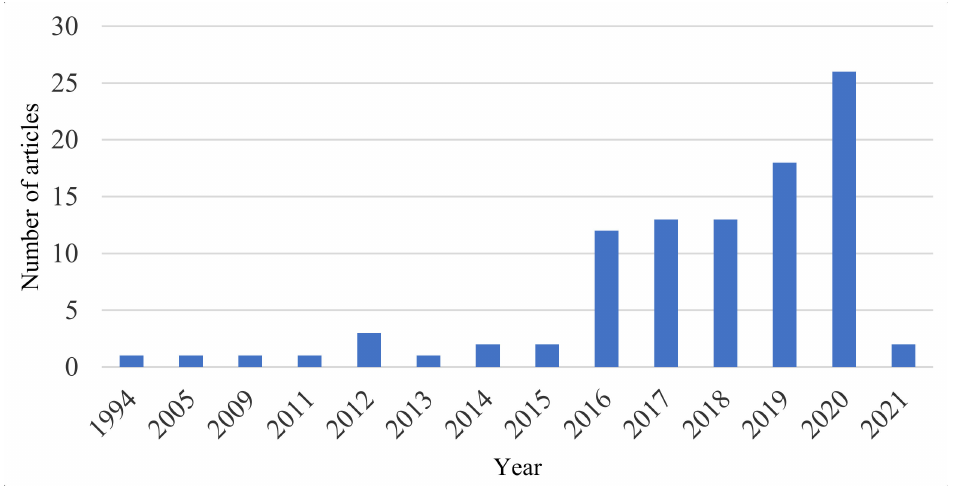
Figure 3. Evolution of the annual number of publications. The main journals present in the final sample that have at least three articles are listed in Table 1. Table 1. Main journals of the sample. Journals Number of